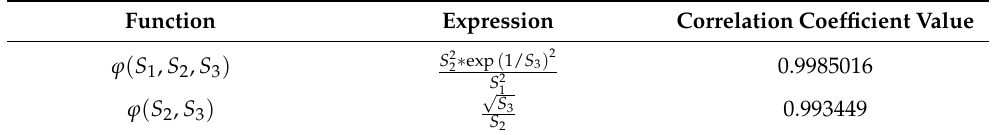
Table 1. The expression of ϕ ( S 1 , S 2 , S 3 ) and ϕ ( S 2 , S 3 ) . Function Expression Correlation Coefficient